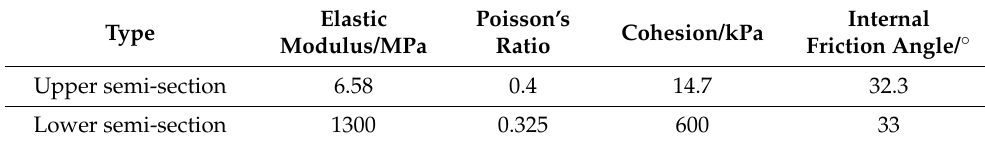
Table 3. Support design in tunnel.